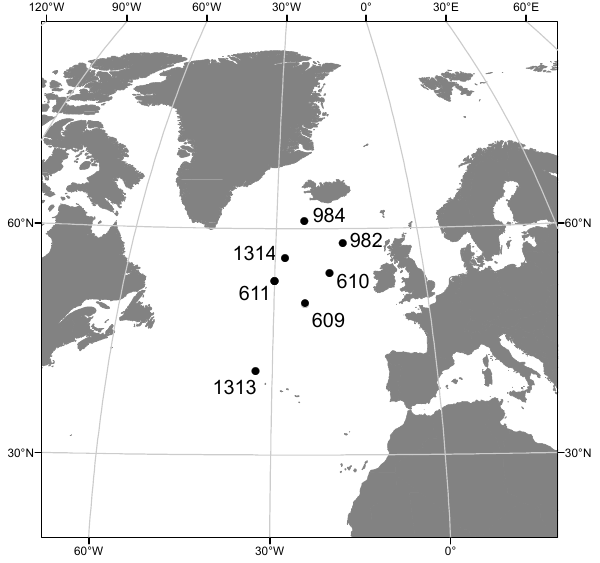
Fig. 1. Site map showing the location of ODP Site 982, as well as other relevant North Atlantic sites.